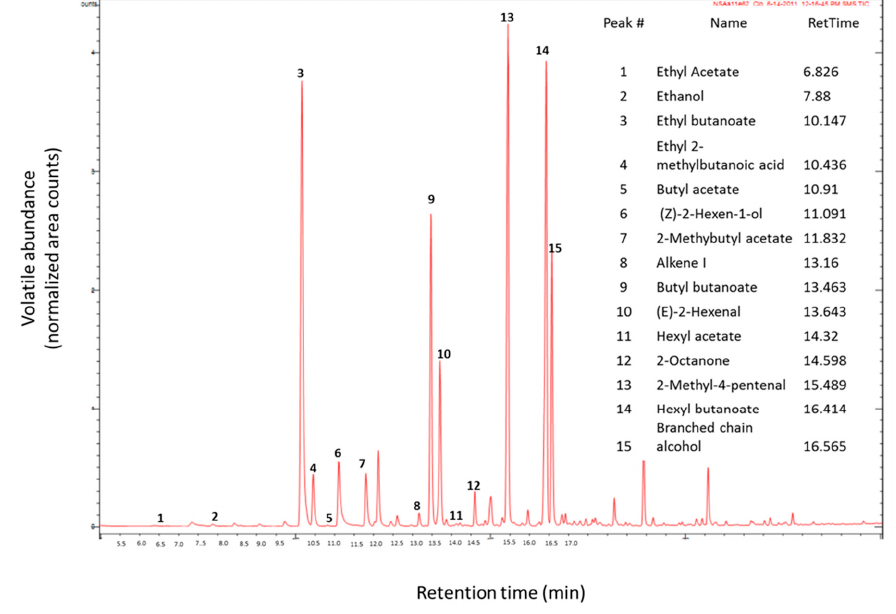
Figure 1. A typical chromatogram for cloudy apple juice from McIntosh apples.